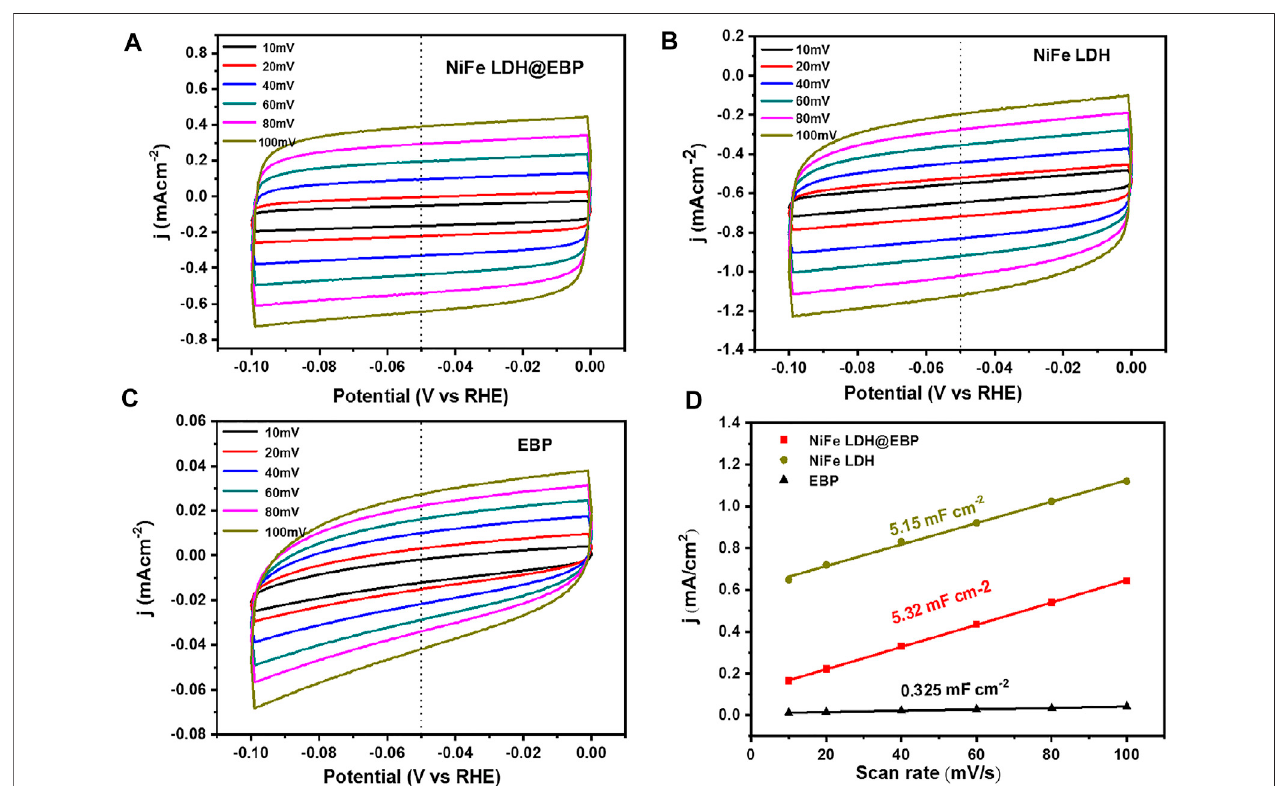
FIGURE6| CVcurvesfor (A) NiFeLDH@EBP, (B) NiFe-LDH,and (C) EBPatvariousscanratesforOER,and (D) double-layercapacitances(C dl )ofNiFeLDH@EBP, NiFe-LDH, and EBP.